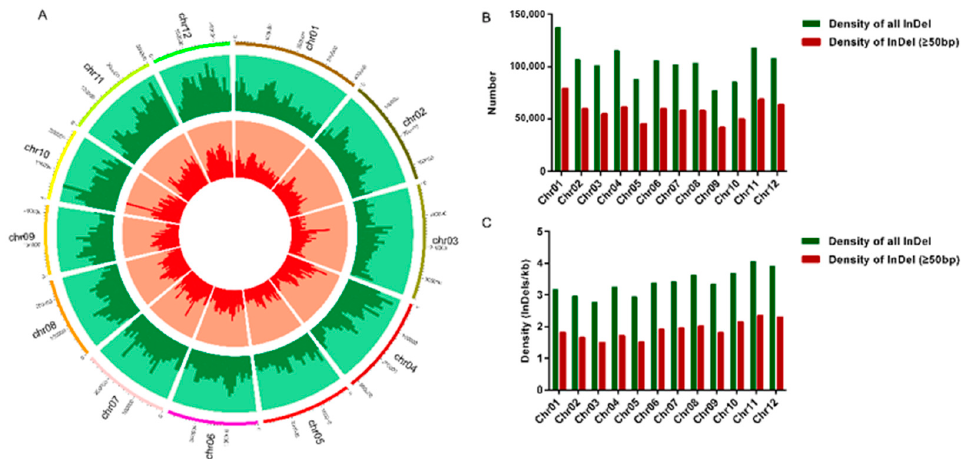
Figure 1. Identification and distribution of InDels in the 3000 Rice Genome Dataset. ( A ) The frequency and relative distribution of InDels physically mapped on 12 chromosomes of Nipponbare genome are illustrated by a circos circular ideogram. The outermost circles signify the different physical size (Mb) of 12 chromosomes, the middle circles represent the number of all InDels per 1 Mb and the distribution on the chromosome, and the inner circles represent the number of 50–1000-bp long InDel per 1 Mb and its distribution on the chromosome. ( B ) The number of all InDels and >50-bp long InDels in various genomic chromosomes. Green represents the number of all InDels and red represents the number of >50-bp long InDels. ( C ) The density of all InDels and >50-bp long InDels in 12 chromosomes. Green represents the density of all InDels and red represents the density of >50-bp long